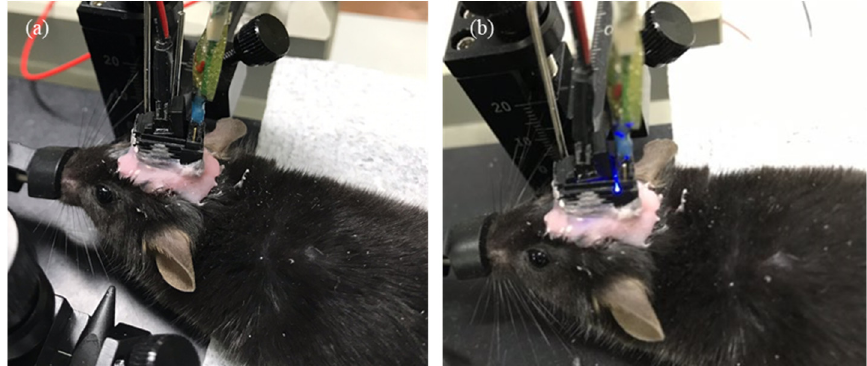
Figure 6. The result of optical stimulation: ( a ) LED light off and ( b ) LED light on.